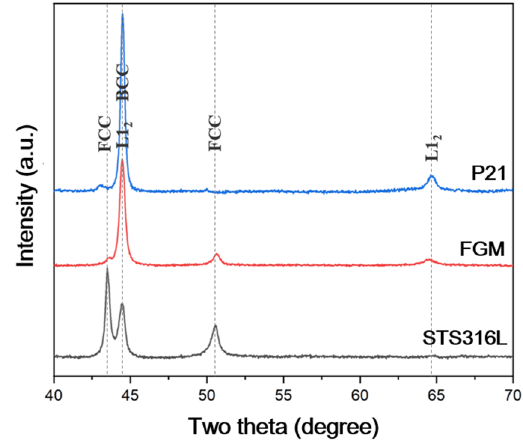
Figure 13. XRD intensity of P21, STS316L and FGM